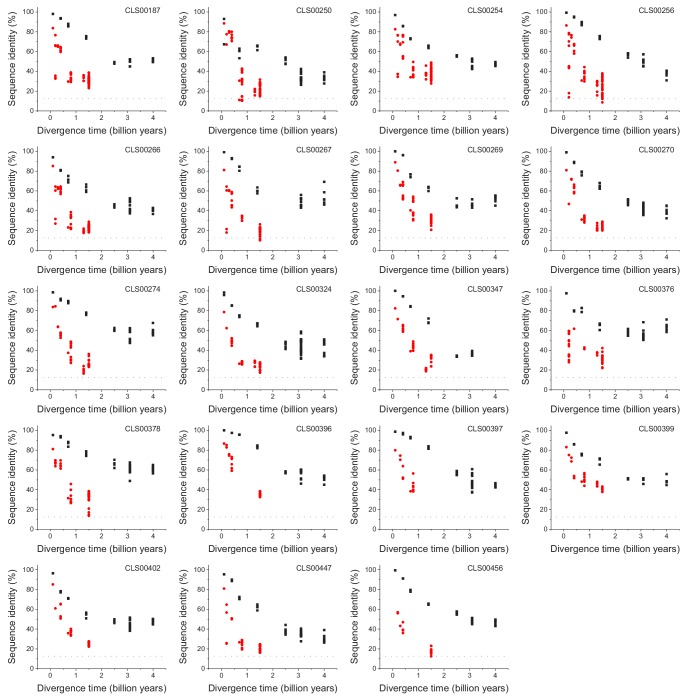
Sequence divergence of mitochondrial ribosomal orthologs as a function of divergence time.Global sequence identity as a function of divergence time for orthologous proteins with substantially different divergence rates between eukaryotic orthologs (red) and pairs of orthologs involving at least one prokaryotic sequence (black). Eukaryotic proteins are mostly annotated as mitochondrial ribosomal proteins and translation initiation factors. The dashed black lines represent the average sequence identity for the global sequence alignment of unrelated protein sequences.10.7554/eLife.39705.012Figure 1—figure supplement 6—source data 1.Sequence identity versus divergence times for mitochondrial ribosomal orthologs.